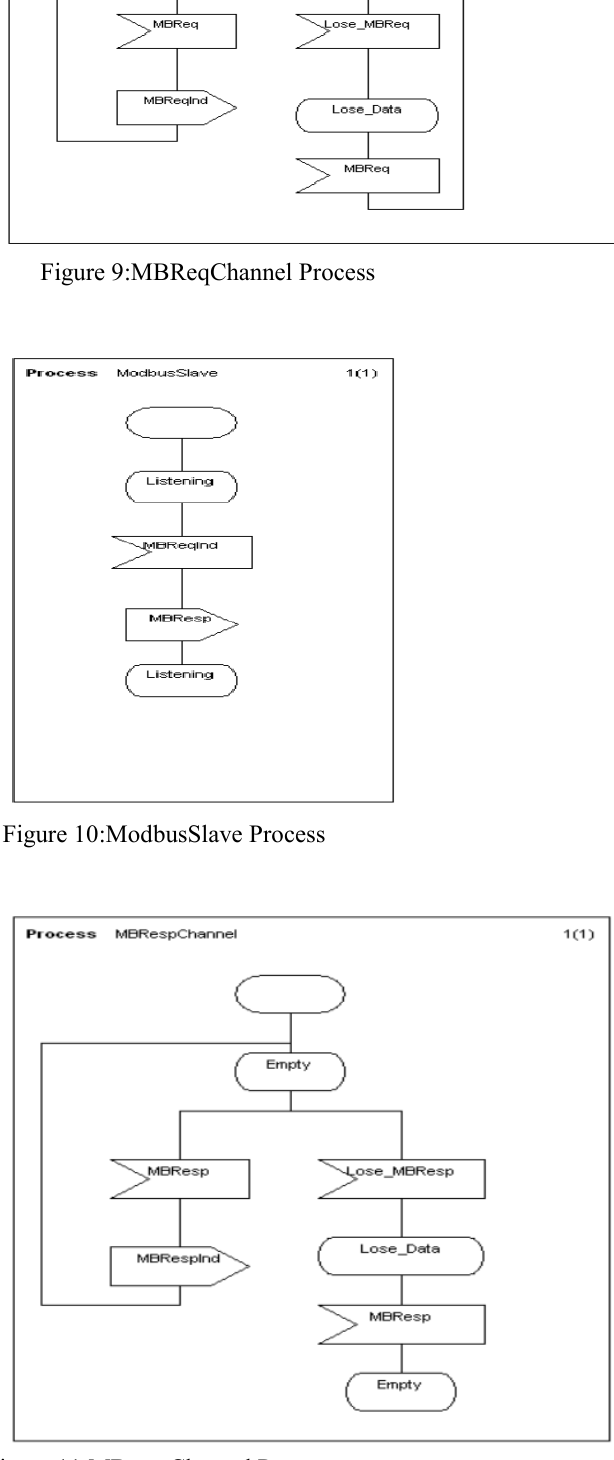
FiFigure 11:MBrespChannel Process